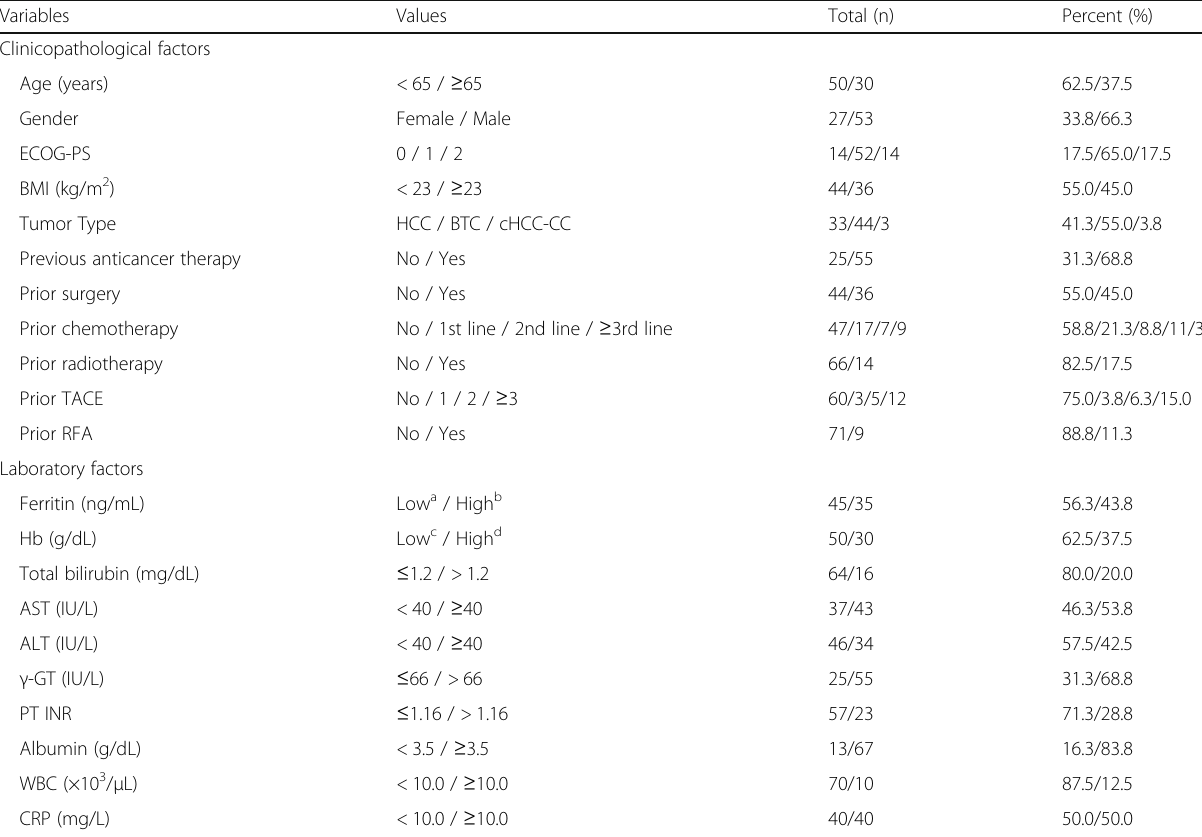
Table 1 Baseline characteristics in patients with advanced hepatobiliary cancers ( n = 80)